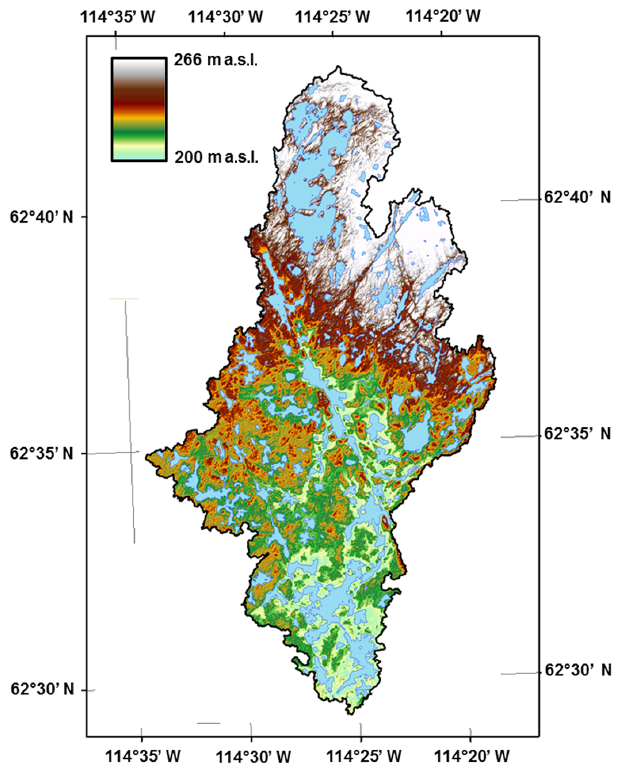
Figure 3. Baker Creek elevation (ma.s.l.) derived from the LiDAR